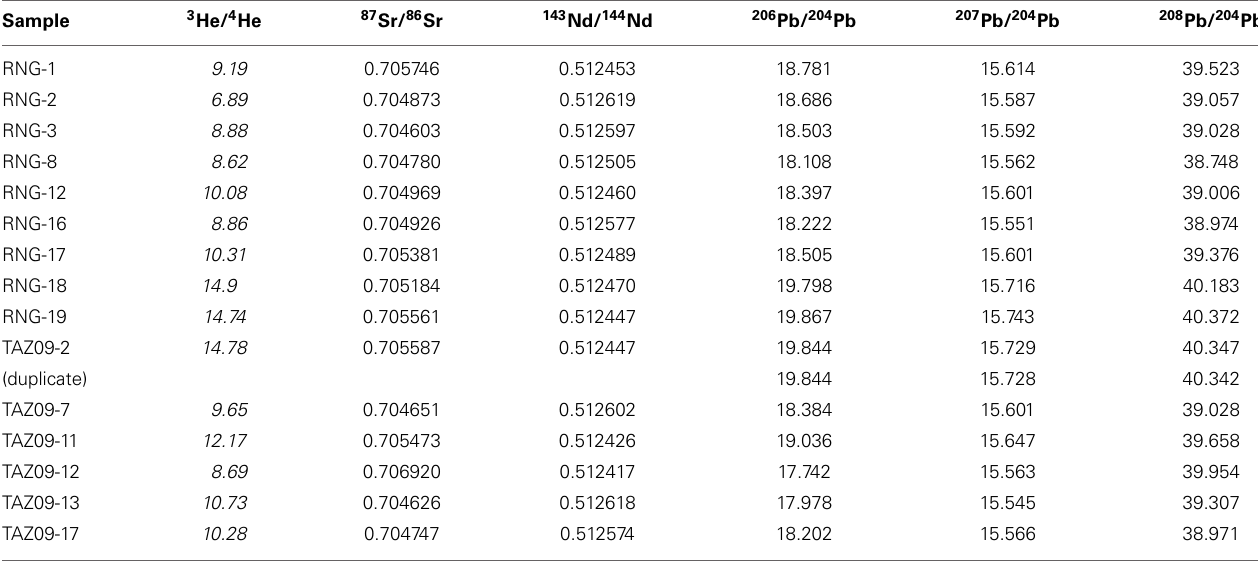
Table 2 | Strontium, Nd and Pb isotopic composition of RVP basaltic rocks and tephras.